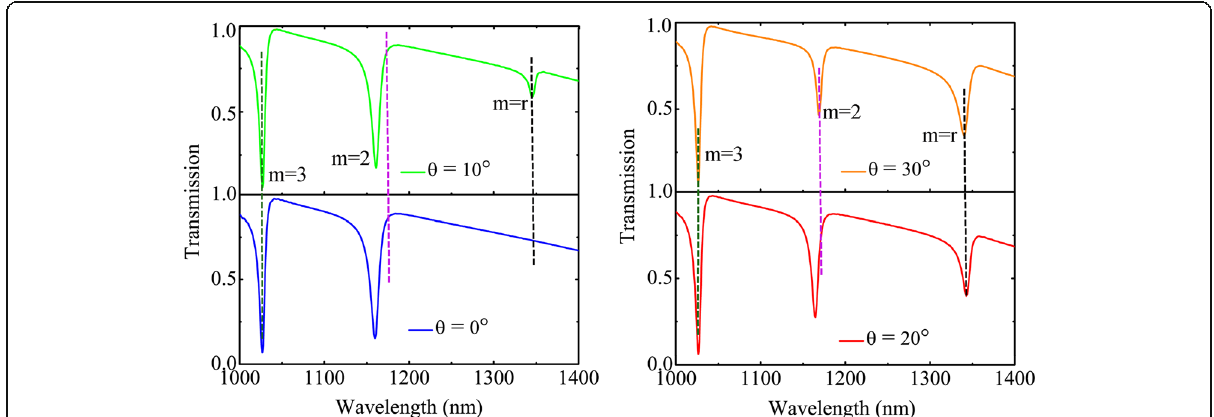
Fig. 5 The blue, green, red, and origin line present the simulation transmission spectra for various right-hand rotation angle θ = 0°, 10°, 20°, and 30°, respectively, with the other parameters same as Fig.